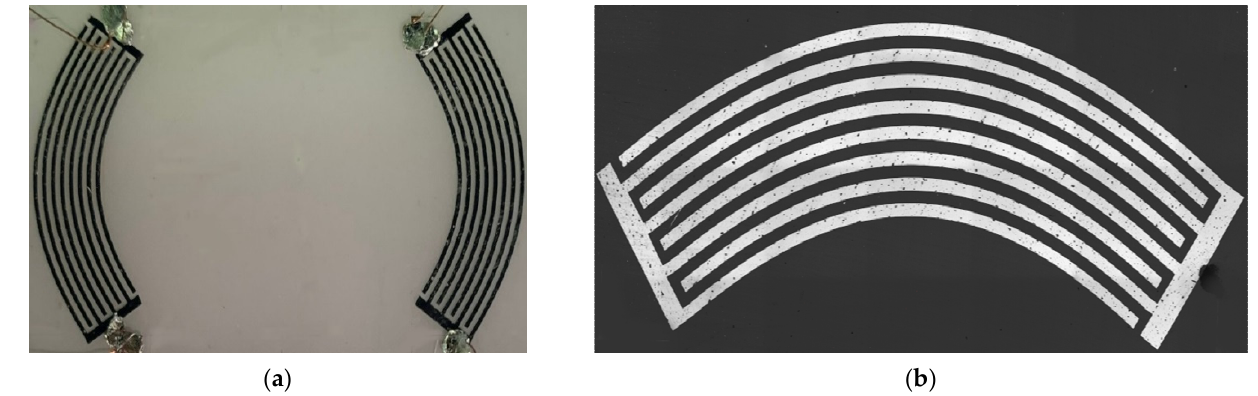
Figure 7. Photos of ( a ) the delay line with focusing IDT with electrodes with variable radius of curvature, and ( b ) en- larged IDT.